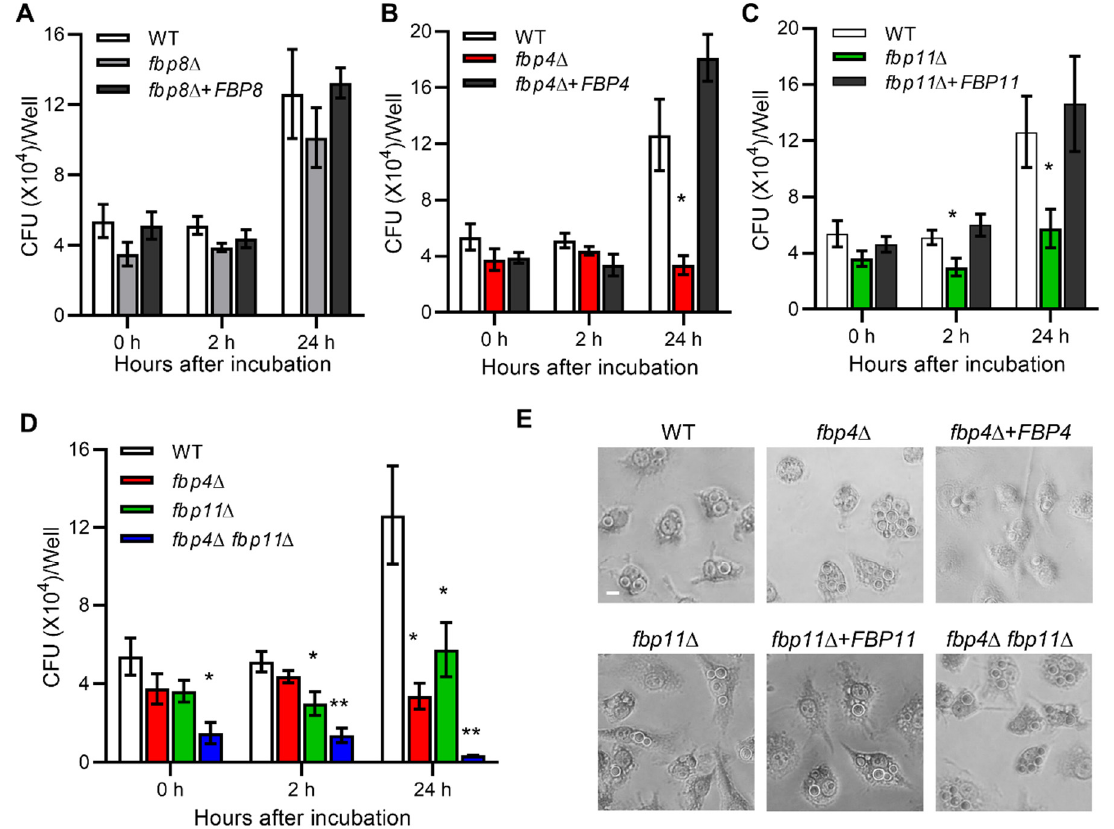
Figure 4. Fbp4 and Fbp11 are important for Cryptococcus -macrophage interactions. Statistical analysis for all measurements in this figure was performed with the Kruskal–Wallis nonparametric test for multiple comparisons. *, p ≤ 0.05. **, p ≤ 0.01. ( A – C ) Killing assay of fbp8 ∆ ( A ), fbp4 ∆ ( B ), fbp11 ∆ ( C ). Phagocytosis was allowed to occur for 2 h to measure both fungicidal and fungistatic activity. After each time interval, macrophages were lysed by adding sterile ddH 2 O. Cells were plated on YPD agar plates and counted to determine CFU. ( D ) Killing assay of fbp4 ∆ , fbp11 ∆ , and fbp4 ∆ fbp11 ∆ strains. ( E ) Typical field views of phagocytosis for each sample.